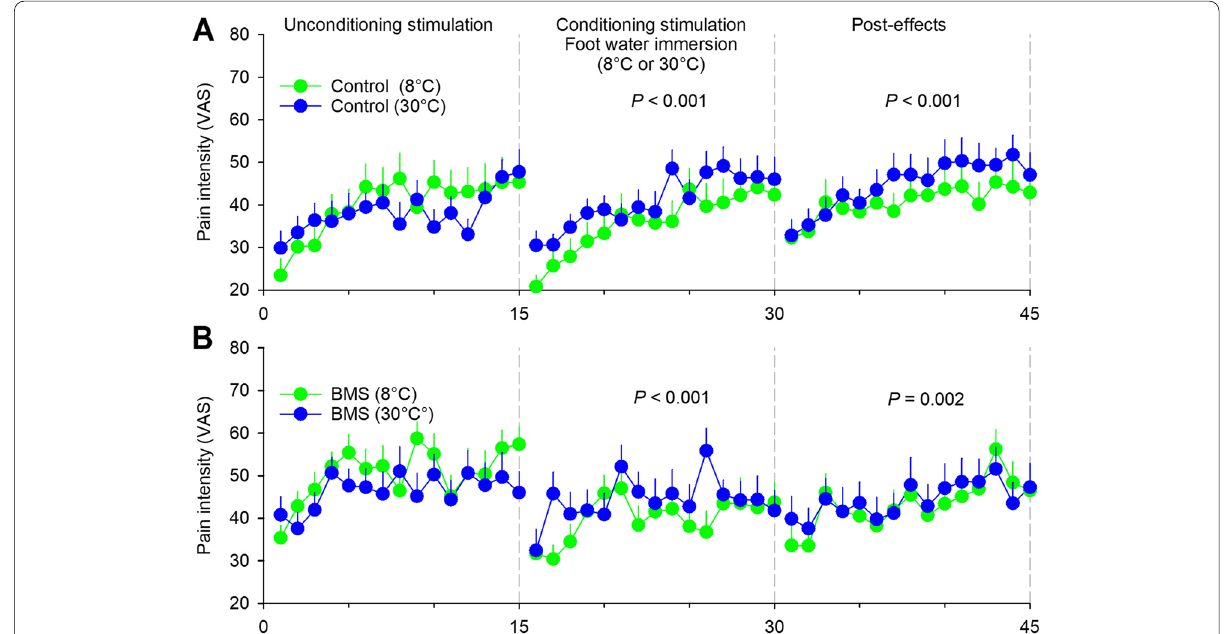
Fig. 2 Time course of pain perception evoked by repetitive painful stimuli of the hand before (1st to 15th), during (16th to 30th), and after (31st to 45th) application of non‑painful (in yellow) or painful (in green) conditioning thermal stimulation on the contralateral foot in ( A ) control subjects and ( B ) burning mouth syndrome patients. To assess CPM, blocks of 4 thermal test stimuli (Nd:YAP laser stimulator) were delivered at 0.2 Hz on the back of the non‑dominant hand, repeated every 40 s for 30 min, at an intensity producing a pain intensity between 3–6 on 0–10 VAS. Between the 10th and 20th min (16th to 30th), the contralateral foot was immersed into a water bath at non‑painful (30 °C) or painful cold (8 °C) temperature. A linear mixed model was used to explore the effects of CPM. P values indicate the differences between the non‑painful and painful conditioning thermal